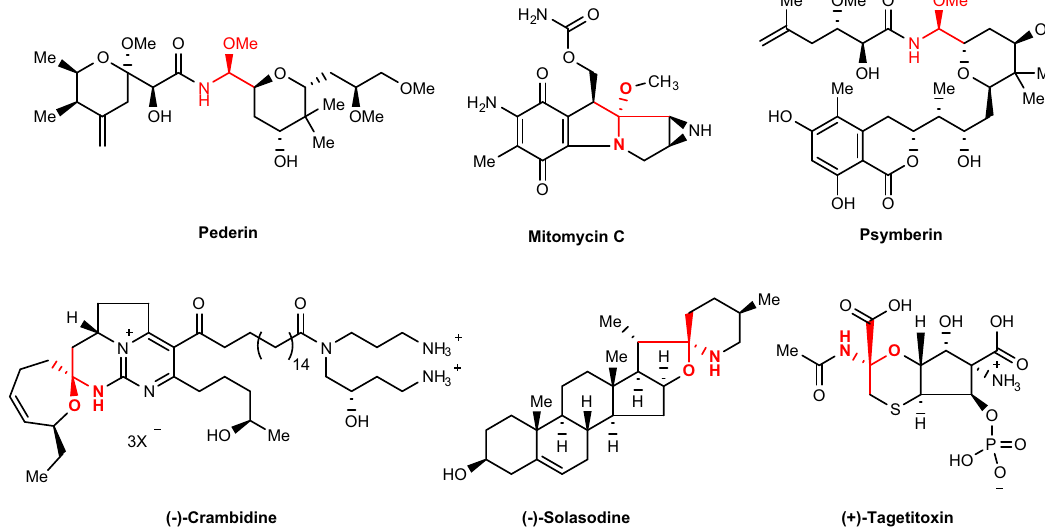
Fig. 1 Examples of biologically molecules with N , O -acetal-structures. Natural products and bioactive molecules containing the chiral N , O -acetal-structures.